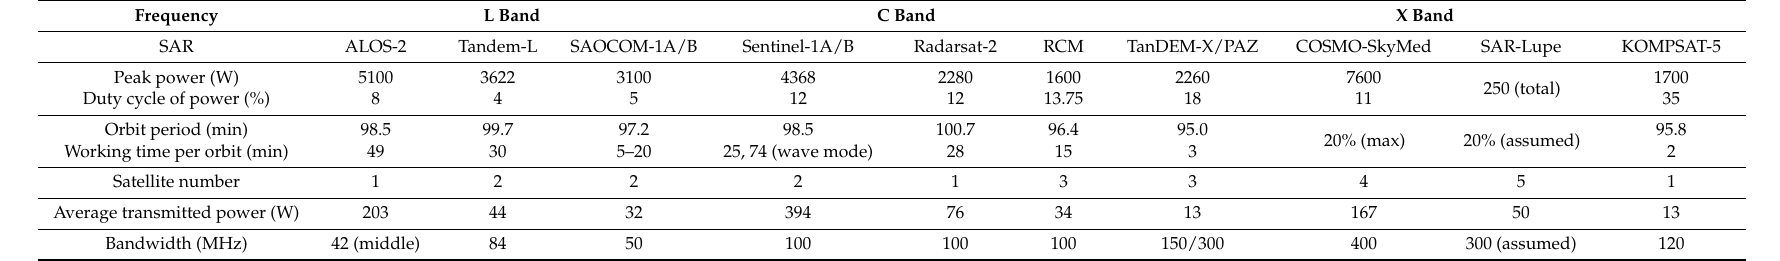
Table 4. Utilized system parameters of the main LEO SAR (L, C and X bands) in the